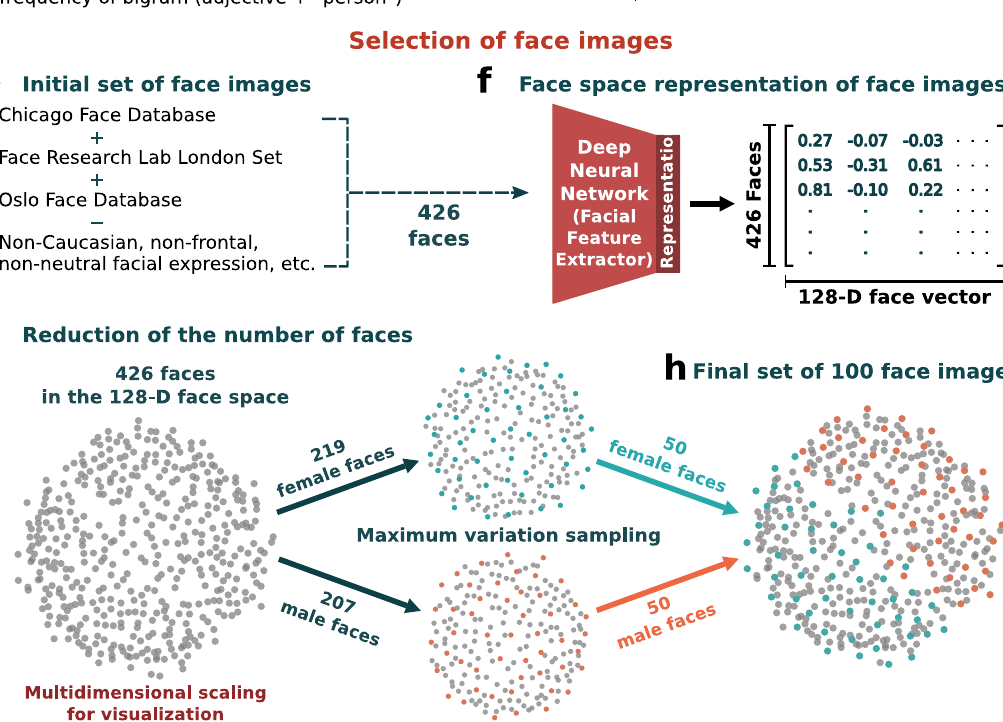
NATURE COMMUNICATIONS| (2021) 12:5168 |https://doi.org/10.1038/s41467-021-25500-y|www.nature.com/naturecommunications